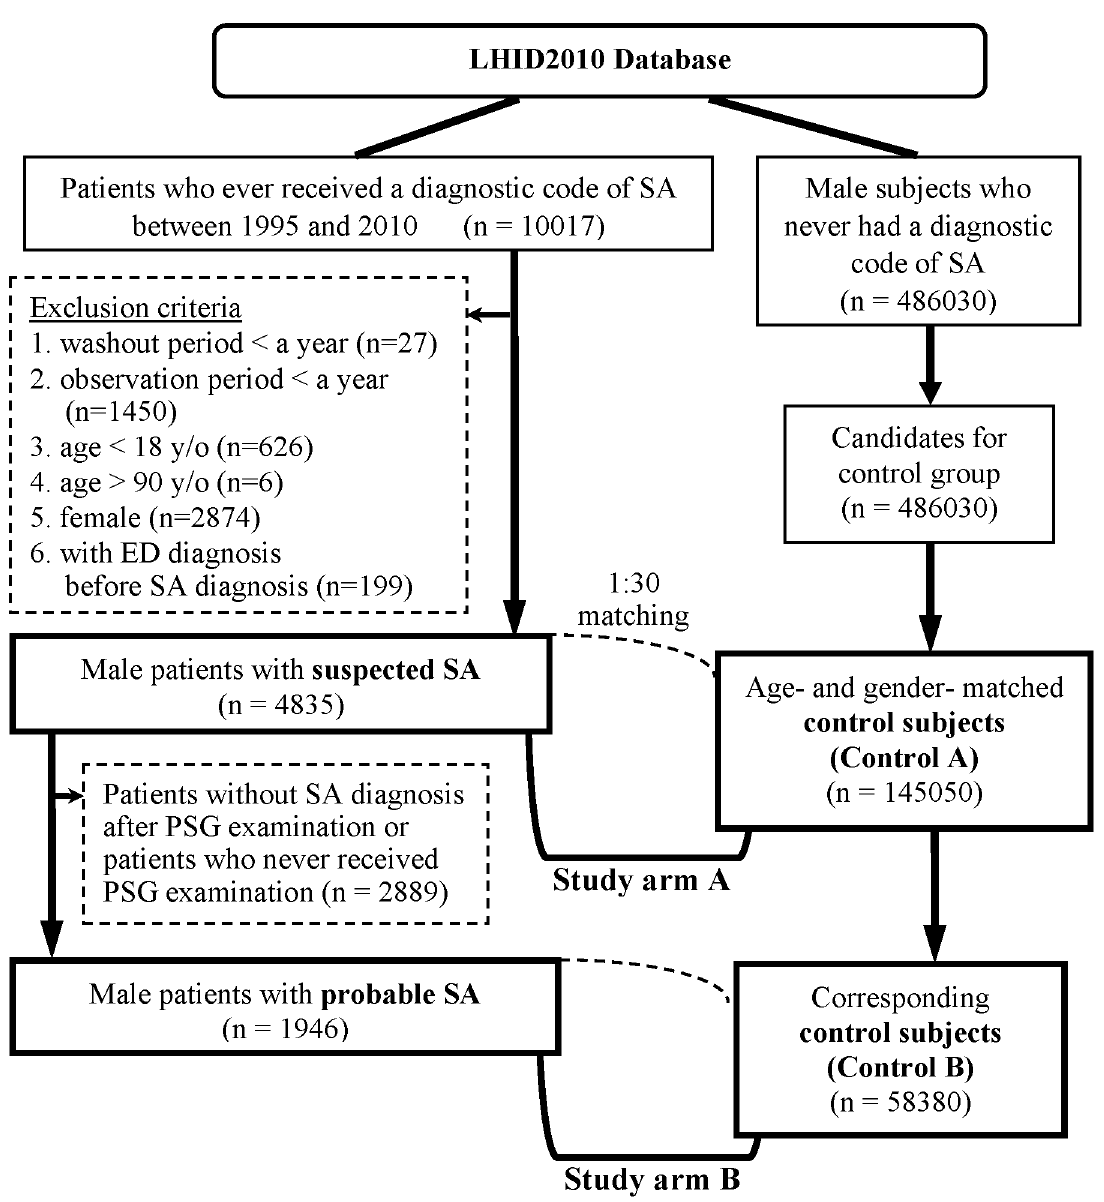
Fig 1. Algorithm for identifying the study population. (Abbreviations: SA = sleep apnea; ED = erectile dysfunction; PSG = polysomnography).